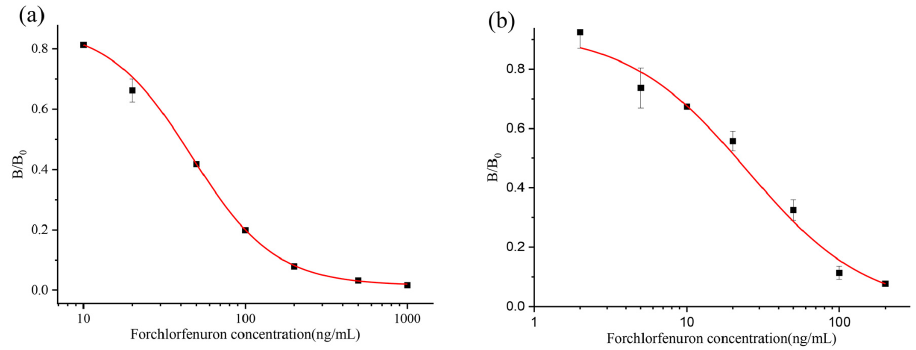
Figure 4. CGN-ICTS curve of CPPU in PB ( a ) 10% methanol-PB ( b ).